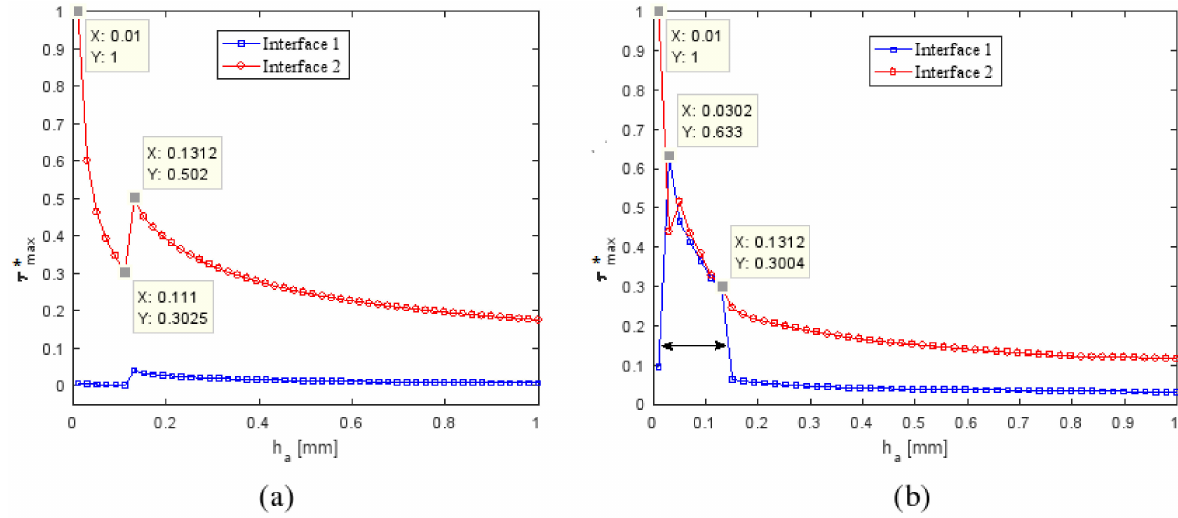
Figure 16. Variation of the maximal normalized shear stress ratio τ ∗ max in interface (1) and interface (2) as a function of adhesive thickness h a in: ( a ) XZ plane; ( b ) YZ